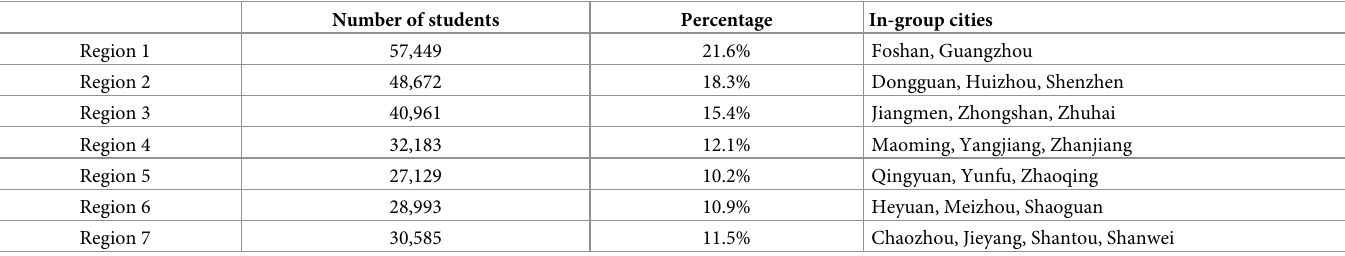
Table 1. The numbers and the percentages of students coming from each city